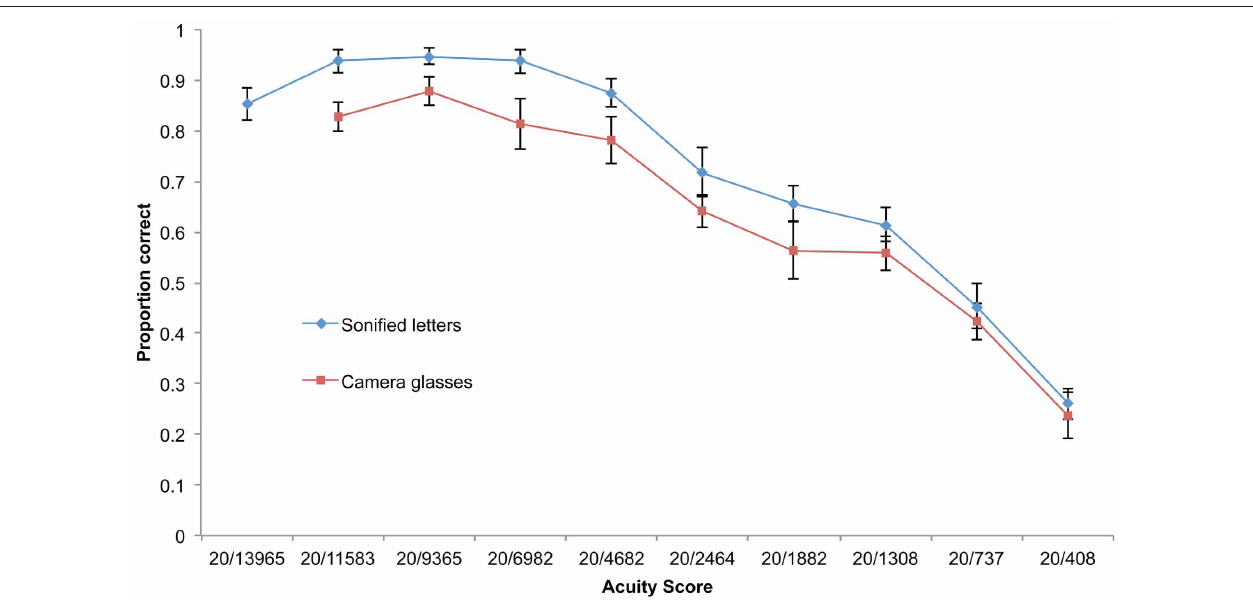
FIGURE 8 | Performance on each acuity category shown as a function of increasing acuity score for static letters and use of camera glasses to sonify letters on screen in real time. Error bars represent standard error of the mean.